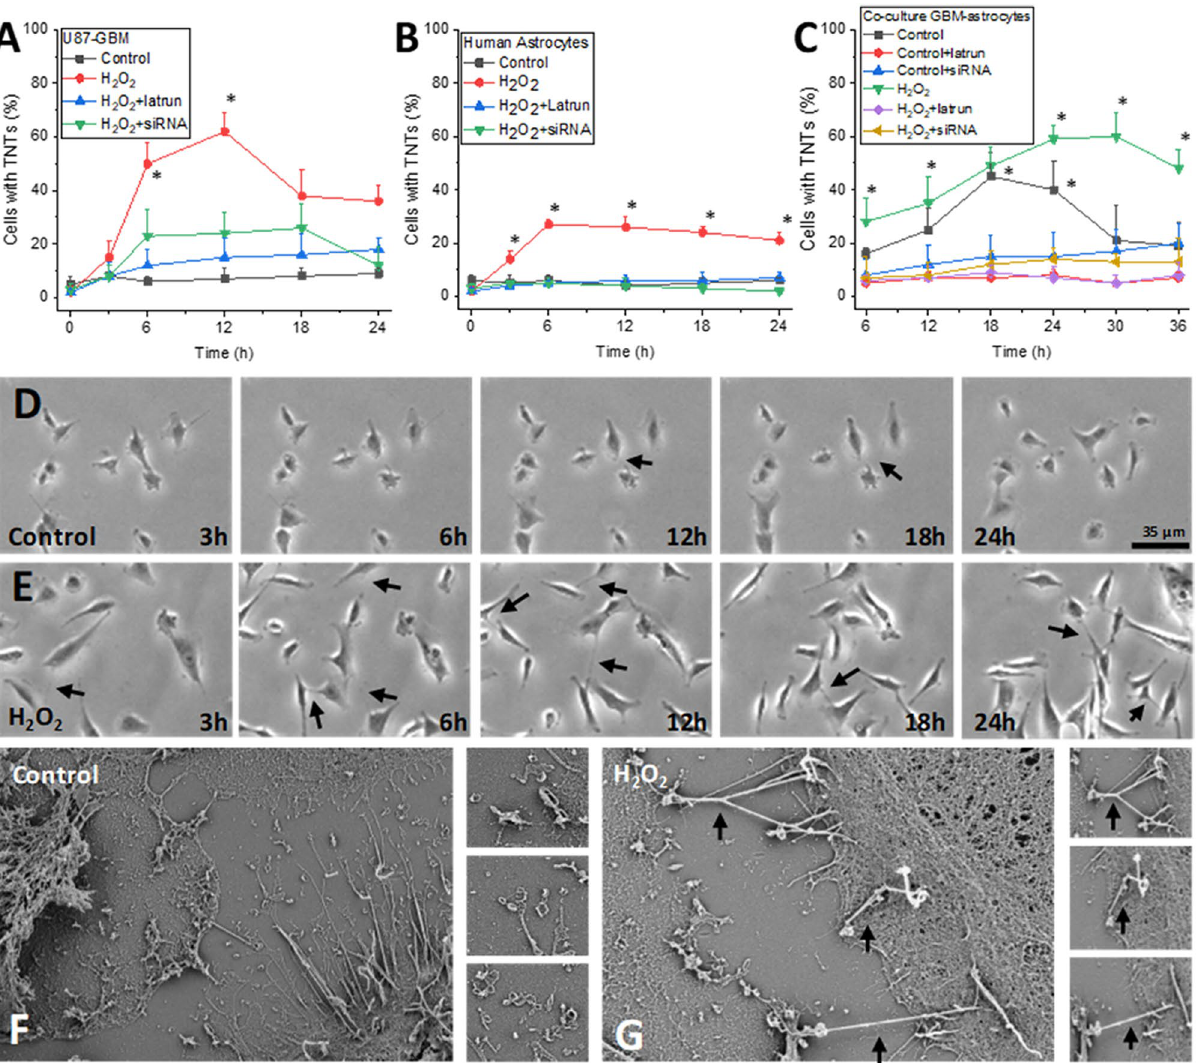
Figure 1. GBM cells communicate with human primary astrocytes via TNT. ( A ) Cultures of U87CD4CCR5 cells (U87GBM) in untreated (control) and H 2 O 2 conditions indicate that oxidative stress increased the number of cells with TNT (*p ≤ 0.005 as compared to untreated control conditions, n = 6–8). Treatment with latrunculin (latrun) or siRNA to TTHY1(siRNA) prevented the formation of TNT induced by H 2 O 2 . ( B ) Quantification of TNT expressing human primary astrocytes (human astrocytes) in response to control and H 2 O 2 conditions indicates a lower TNT formation than U87-GBM cells (*p ≤ 0.005 as compared to TNT blockers). Treatment with latrunculin (latrun) or siRNA to TTHY1(siRNA) prevented the formation of TNT induced by H 2 O 2 . ( C ) Time course of TNT formation between GBM cells, U87-GBM, and human primary astrocytes under control or H 2 O 2 conditions. Treatment with latrunculin (latrun) or siRNA to TTHY1(siRNA) prevented the formation of TNT (*p ≤ 0.005 as compared to TNT blockers). ( D ) Representative time course of TNT formation in control conditions after 3, 6, 12, 18, and 24 h post imaging. ( E ) Time course of TNT formation upon H 2 O 2 conditions, live-cell imaging after 3, 6, 12, 18, and 24 h. Arrows denote TNT structures. ( F ) Scanning electron microscopy of co-cultures of U87-GBM and primary human astrocytes under control conditions. Distinct filopodia are shown in the small inset images. ( G ) Denotes TNT induced by H 2 O 2 conditions. Distinct TNT are shown in the small inset images, and at the bottom, it is possible to observe filopodia. Arrows denote TNT structures (cells analyzed per experiment were 35.3 ± 8.741, n = Evaluation of TNT by transmission electron microscopy indicates that, in GBM cells, mito‑ chondria at the TNT formation area are enlarged. To determine the biological differences between filopodium and TNT as well as the structures associated with TNT formation, we used transmission electron microscopy (TEM) to examine the top and bottom optical area of the cells using the coculture system described above. To perform these experiments, the bottom (filopodium localization) and the top (TNT localization) opti- cal planes of the cells were sectioned and analyzed by TEM. We focused on the U87-GBM cells establishing